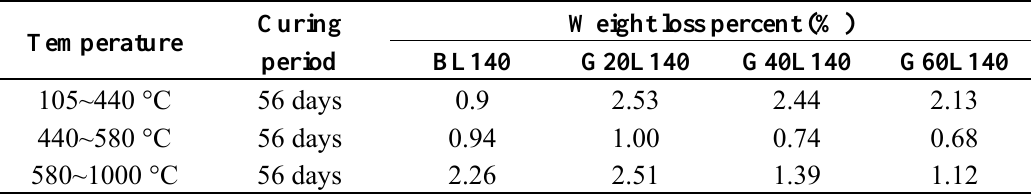
Table 9. Weight loss of the specimen with slag admixture under different temperature after leaching.